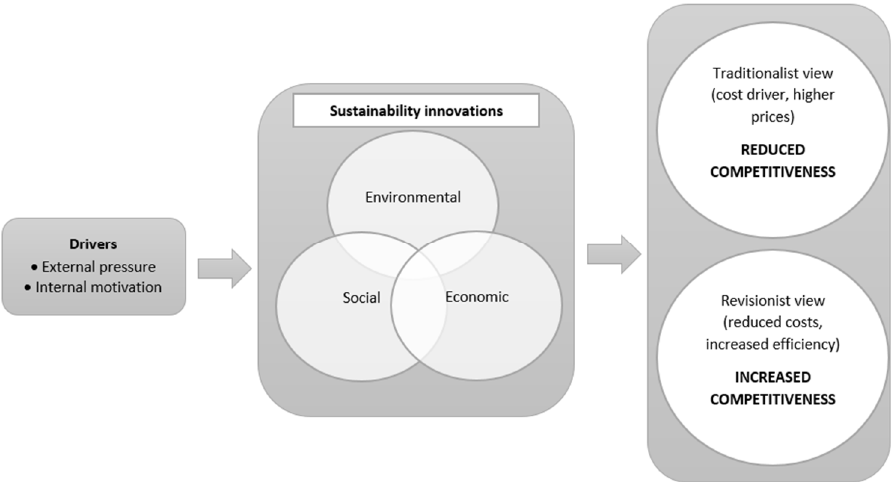
Figure 1. Aspects of sustainability innovations. Source: based on Hermundsdottir and Aspelund (2020), edited by the authors.